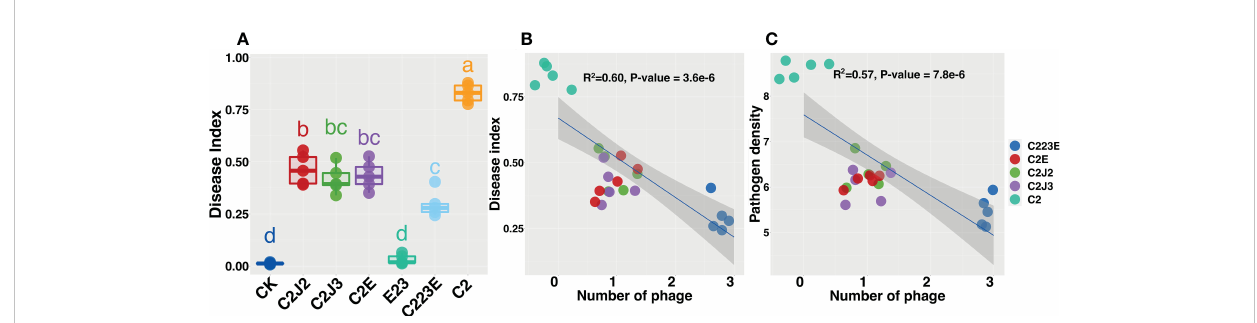
FIGURE 1 Effects of phages on rice bacterial blight disease index (A, B) and pathogen density (C) . All relationships were analyzed using linear regression analysis. R 2 and P -value refer to the most parsimonious models. The different letter indicates a signi fi cant difference at the level of P < 0.05 by the Kruskal-Wallis test. CK: Control; C2: Xoo strain alone; C2J2, Xoo strain C2 + Xoo phage J2; C2J3, Xoo strain C2 + Xoo phage J3; C2E, Xoo strain C2 + Xoo phage E; C223E, Xoo strain C2 + Xoo phages